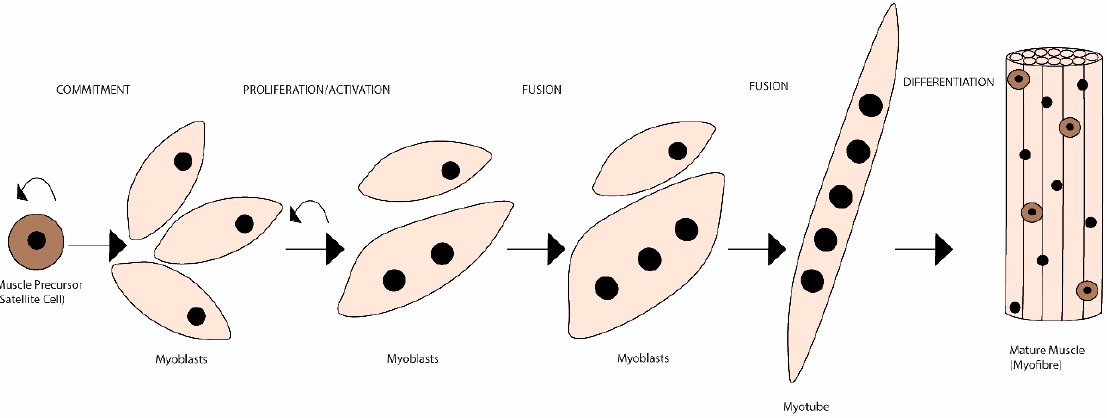
Figure 1. Schematic representation of the mammalian skeletal myogenesis process. Upon muscle injury, a resident population of quiescent skeletal muscle satellite cells can become activated, start to proliferate and differentiate into myoblasts. Over the course of several days, these myoblasts fuse together to form multinucleated myotubes. Further, myoblasts can also fuse to the already existing myotubes to create even larger myotubes, which will eventually align to form muscle fibres. This whole process is regulated by many internal and external cues.